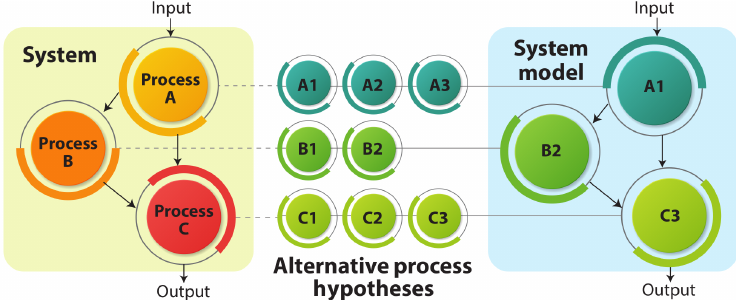
Figure 1. Schematic to illustrate a real-world system (yellow box) comprised of three processes (red shapes). Multiple hypotheses or as- sumptions exist for each process: three for process A, two for process B, and three for process C. When a modeller is building a conventional model of the system (blue box) they are faced with the choice of which hypothesis or assumption to use for each process in their model. In this illustration, the model is composed of hypothesis A1 for process A, hypothesis B2 for process B, and hypothesis C 3 for process C. MAAT allows a modeller to use all available hypotheses for each process and compare them using formal and informal methods. In this illustration, a total of 18 possible models exist. The addition of one more process with three alternative representations would increase the number of possible models to